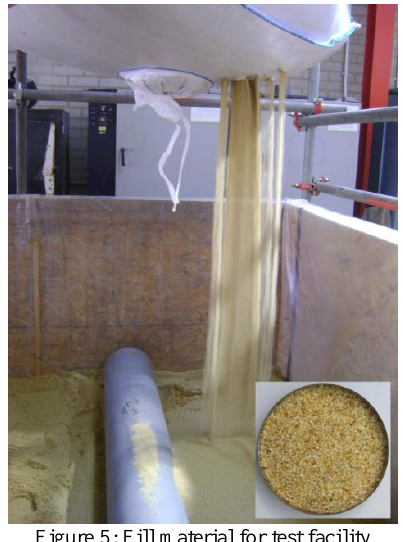
Figure 5: Fill material for test facility